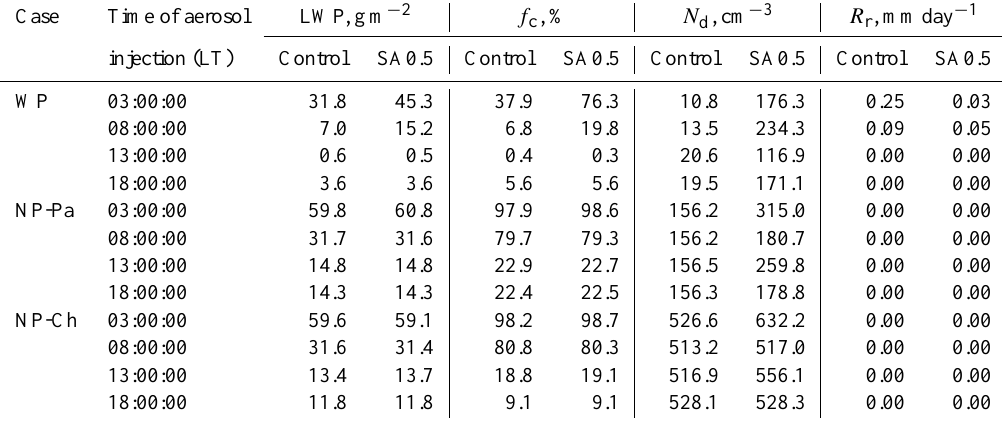
Table 2. Results for the SA0.5 aerosol injection rate. Domain and time-period averaged liquid water path (LWP, gm − 2 ) , cloud fraction ( f c , %), cloud droplet number concentration ( N d , cm − 3 ) and surface rain rate ( R r , mmday − 1 ) . The time average is taken for the times of SW radiation present in the 5 h subsequent to aerosol